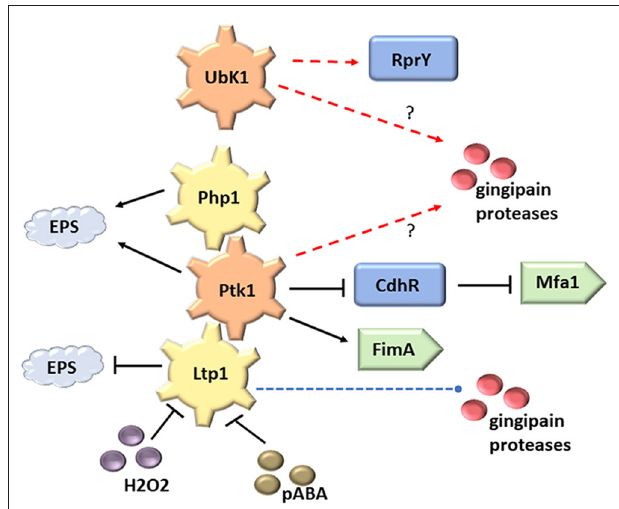
FIGURE 1 | Tyrosine kinases (Ptk1 and UbK1) and phosphatases (Ltp1 and Php1) in P. gingivalis . Both Ltp1 and Php1 can dephosphorylate and inactivate Ptk1. RprY and CdhR are transcriptional regulators controlled by UbK1 and Php1 respectively. The Php1/Ltp1-Ptk1 axis can control production of the FimA and Mfa1 fimbriae and extracellular polysaccharide (EPS). Processing and secretion of gingipain proteases requires specific patterns of tyrosine phosphorylation. Secreted Ltp1 can be inactivated by peroxide and pABA. Red dashed line indicates direct phosphorylation and blue dashed line indicates direct